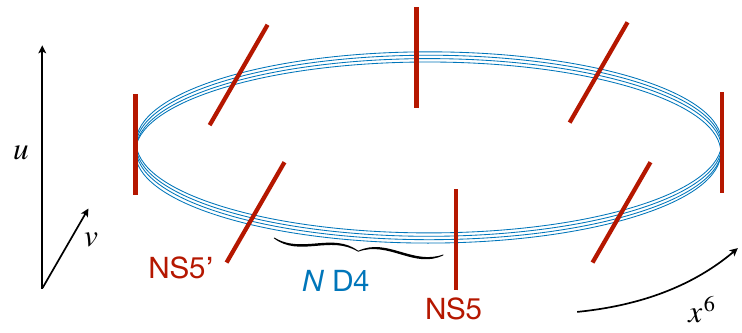
Figure 4 . IIA picture of a 4d N = 1 necklace quiver with n SU( N c ) gauge groups: the relative rotation between two consecutive NS5-NS5’ branes breaks supersymmetry from N = 2 to N = 1